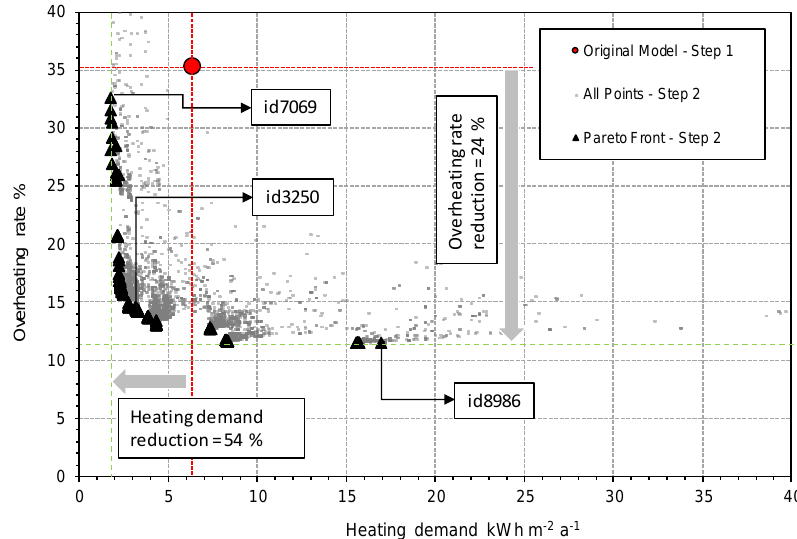
Figure 5. Pareto front using all simulated results: Steps 1 and 2.